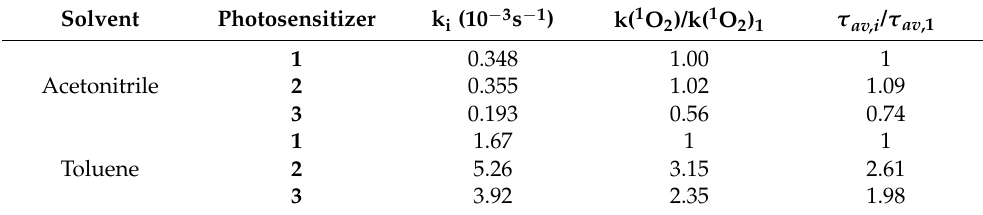
Figure 11. DMA fluorescence intensity (normalized to the zero-time value) as a function of irradiation time for solutions of DMA added with 1 (red squares), 2 (blue circles), and 3 (magenta triangles) in ( a ) toluene and ( b ) acetonitrile. The solid lines represent the best fits to a single exponential decay model function. The effects of DMA intrinsic fluorescence fading were taken into account as detailed in the Materials and Methods section. Table 11. DMA fluorescence fading decay constants, obtained by fitting the data of Figure 11 (column three), are used to extract estimates of the relative 1 O 2 generation quantum yields (column four), which are compared with the relative excited-state stabilities, measured in terms of ratios (column five).